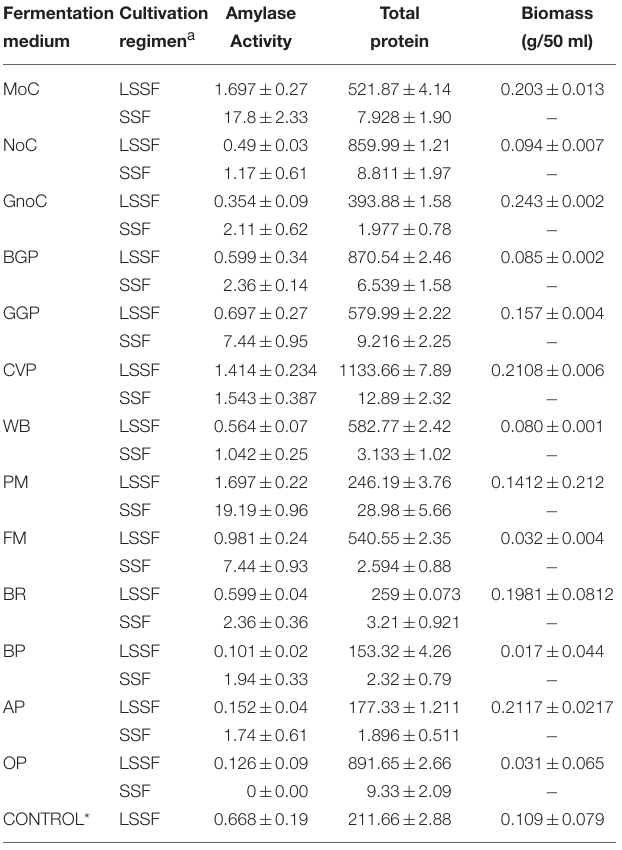
TABLE 2 | Enzyme biosynthesis by Aspergillusterreus NCFT4269.10 in liquid static surface culture and solid state culture systems using various agricultural wastes as the